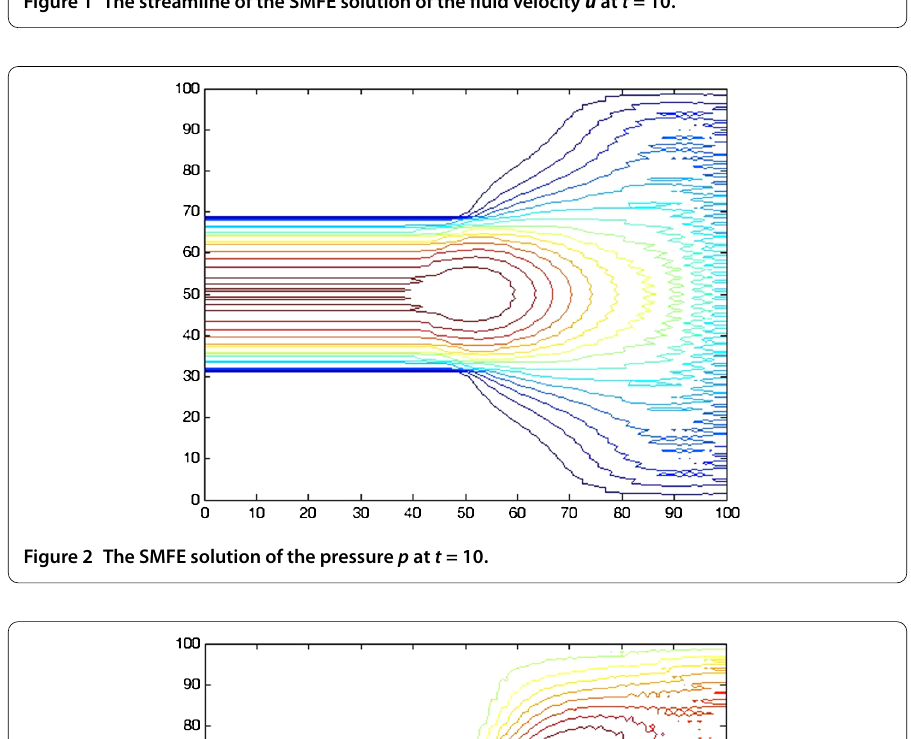
Figure 2 The SMFE solution of the pressure p at t = 10.